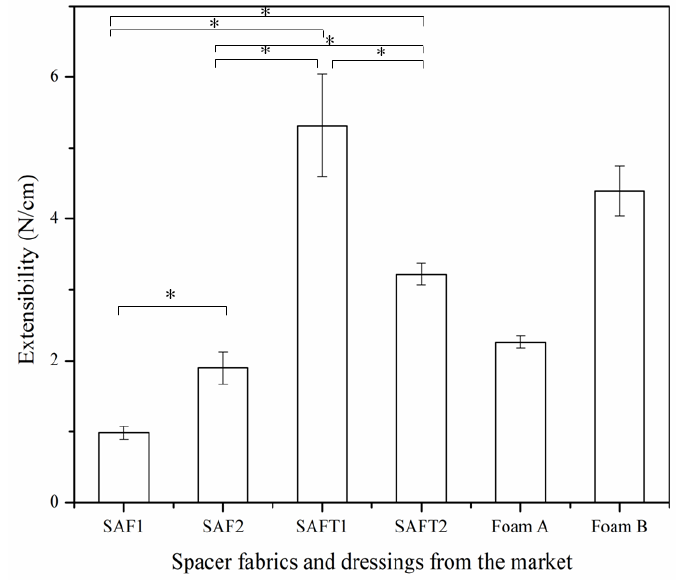
Figure 12. Extensibility of the spacer fabrics and foam dressings from the market. * p < 0.05.